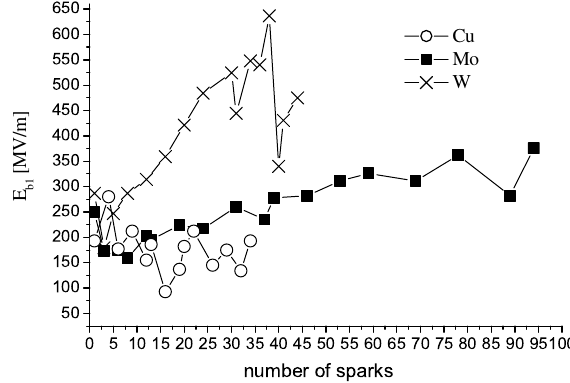
FIG. 2. Conditioning curve: breakdown field (applied) as a function of the number of sparks for one site on Cu (circles) , Mo (squares), and W